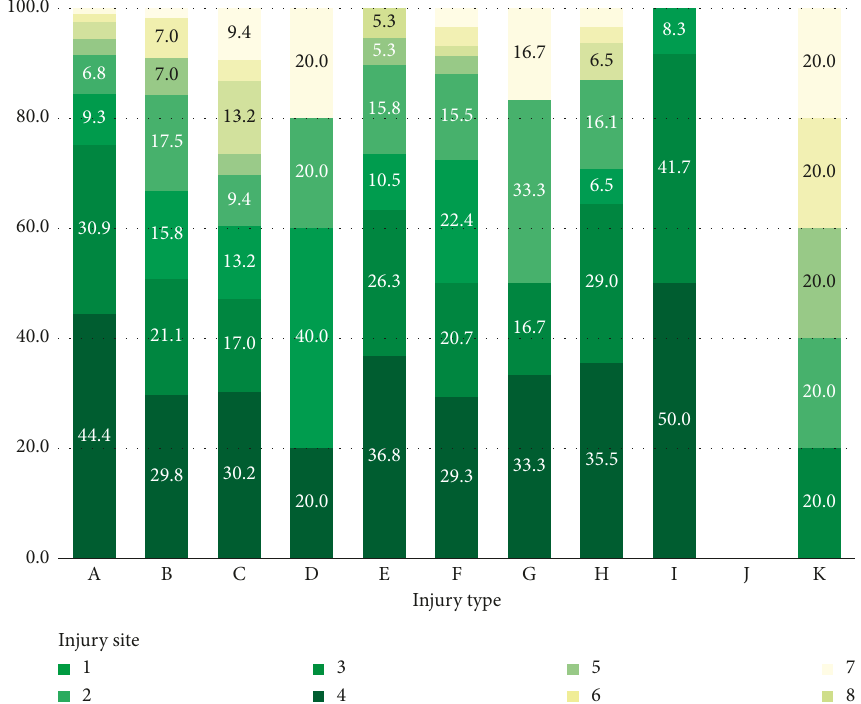
Figure 3: Proportion of abdominal surgery sites by trauma mechanisms. A, car accident; B, motorcycle accident; C, pedestrian accident; D, bicycle accident; E, ship or train accident; F, fall; G, slipping and rolling down; H, bumping injury; I, crush injury; J, explosion burn; K, others; 1, liver; 2, spleen; 3, bowel; 4, mesentery and omentum; 5, pancreas; 6, kidney; 7, bladder; 8,